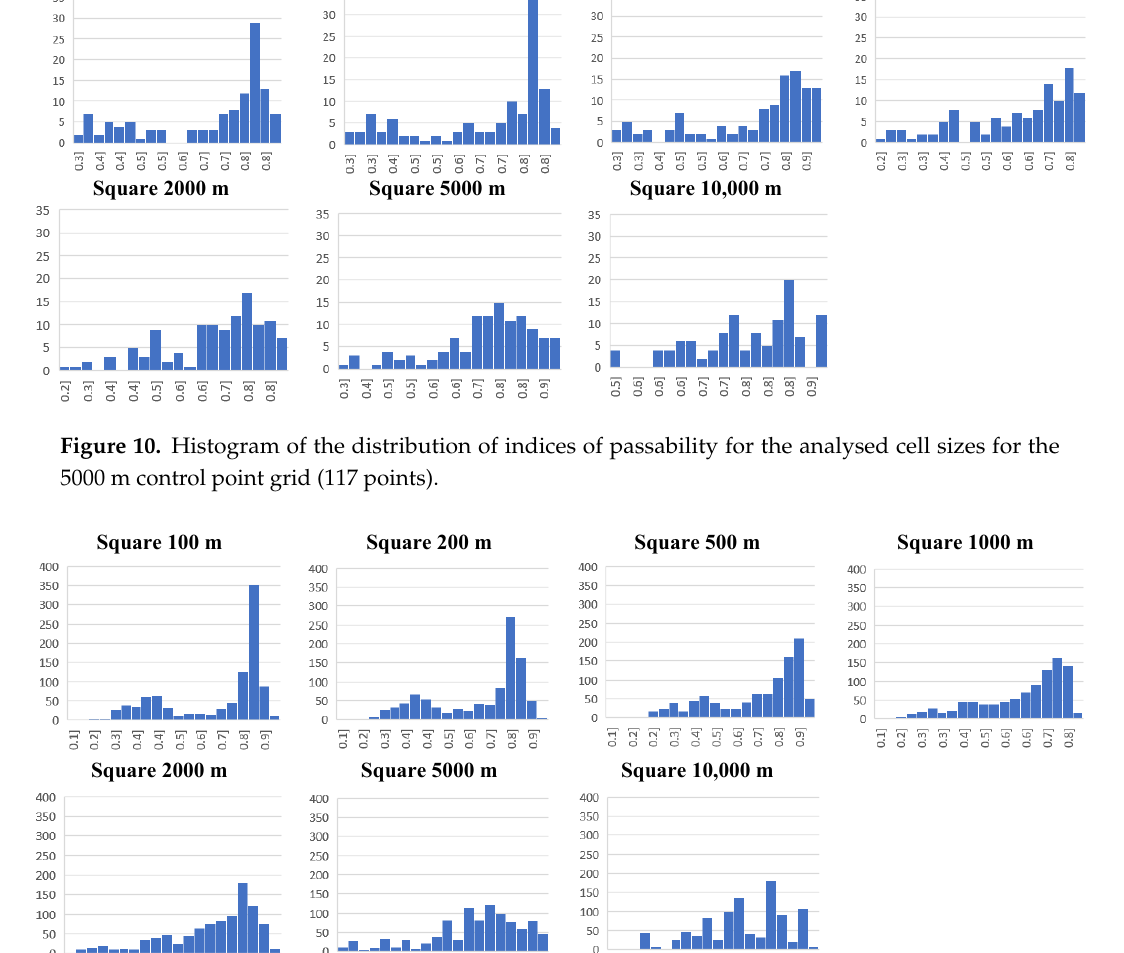
Figure 11. Histogram of the distribution of indices of passability for the analysed cell sizes for 1000 randomly distributed control points.